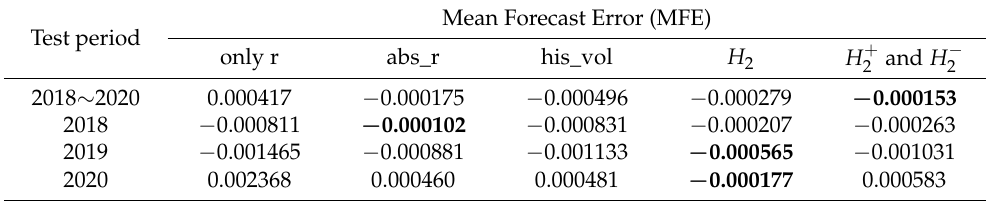
Table 4. Forecasting performance by period with different inputs (Please note that the best results are highlighted in BOLD